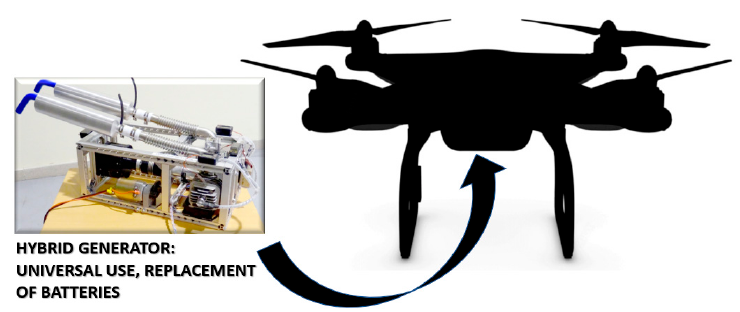
Figure 5. Prototype used as battery replacement in any UAS.